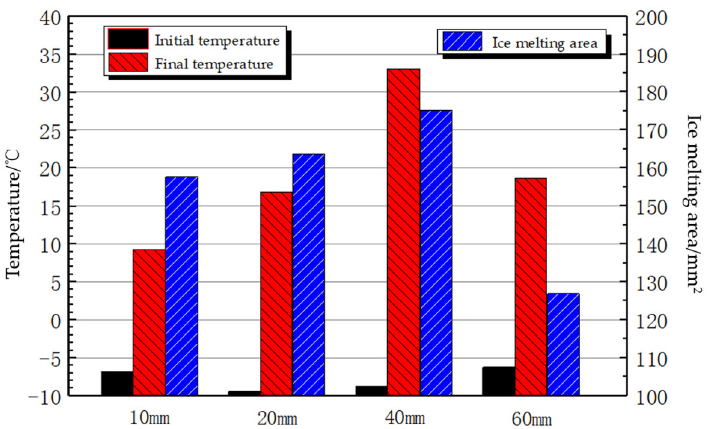
Figure 9. Temperature increase rate at the center point (T 0 ) of concrete specimens with different carbon fiber contents and